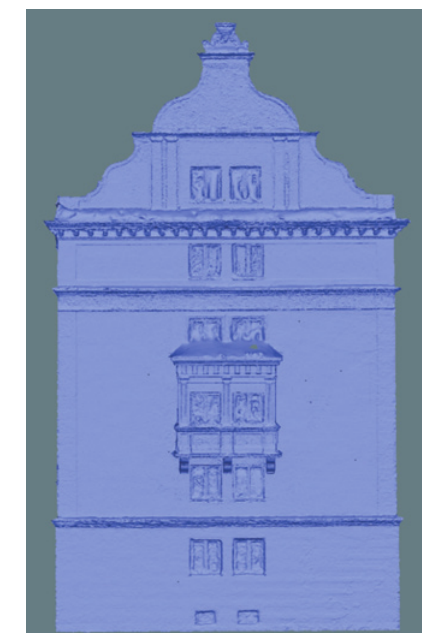
Fig. 9. 3D model of a residential building facade with poor